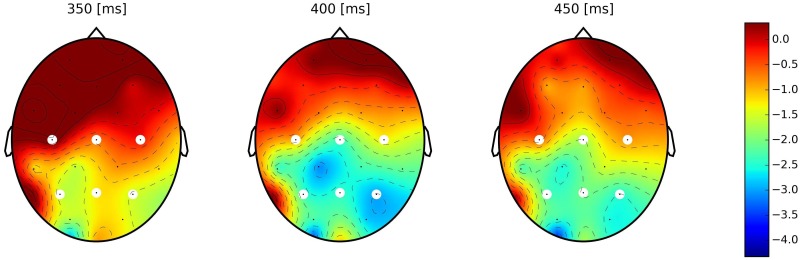
Scalp plots of difference between homograph unrelated and homograph related groups for short experimental version.Each scalp plot represents the average of 50 ms time window (from left to right: 350 to 400 ms, 400 to 450 ms and 450 to 500 ms accordingly). An increase in negativity (N400hu-N400hr) over time is observed.